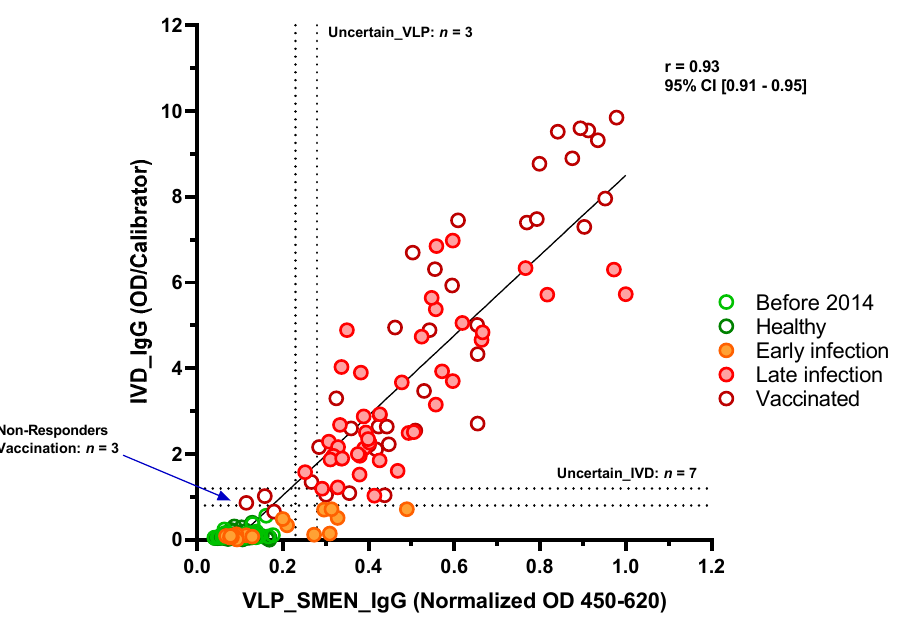
Figure 3. Comparison of the performance of SARS-CoV-2 VLP-ELISA with a certified IVD. Correlation of results from VLP-ELISA with a certified IVD.